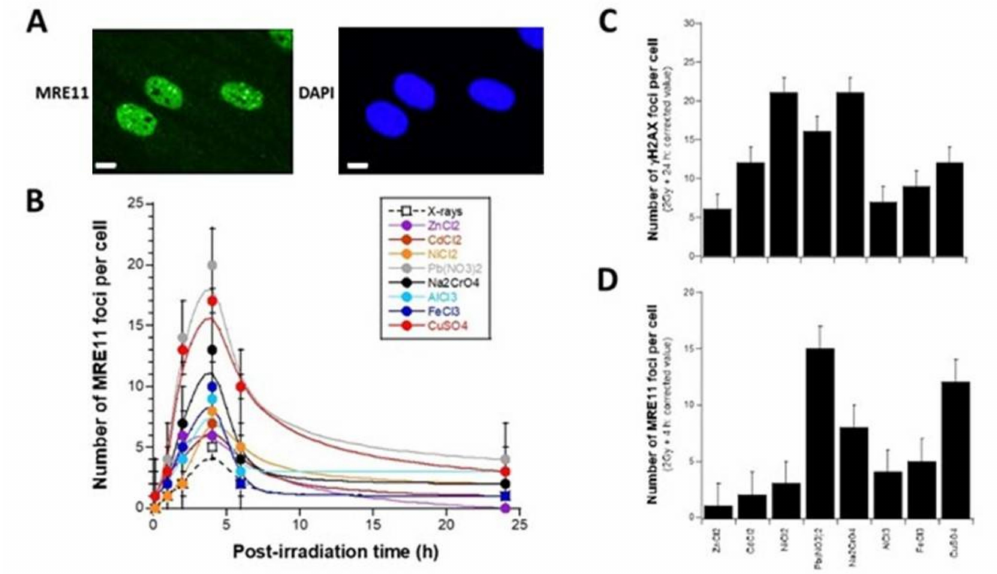
Figure 5. MRE11 foci after exposure of cells to metal. In the same conditions as described in Figure 3 (but only 100 µ M metal was applied), anti-MRE11 immunofluorescence was applied to the radioresistant 149BR control cells. ( A ) Representative example of images stained with anti-MRE11 antibody and counterstained with DAPI after 24 h exposure to 100 µ M AlCl 3 , X-ray irradiation (2 Gy) followed by 4 h for repair. The white bar represents 10 µ m. ( B ) The MRE11 data was obtained after 100 µ M metal incubation followed by 2 Gy X-rays and assessed at the indicated post-irradiation times. Each plot represents the mean ± standard error (SEM) of at least three replicates. ( C ) The number of residual γ H2AX foci obtained after 100 µ M metal as shown in Figure 3 but corrected with the γ H2AX data without metal exposure was plotted at the indicated metallic species. ( D ) The number of the MRE11 foci obtained after 100 µ M metal shown in Figure 5A but corrected with the MRE11 data without metal exposure was plotted at the indicated metallic